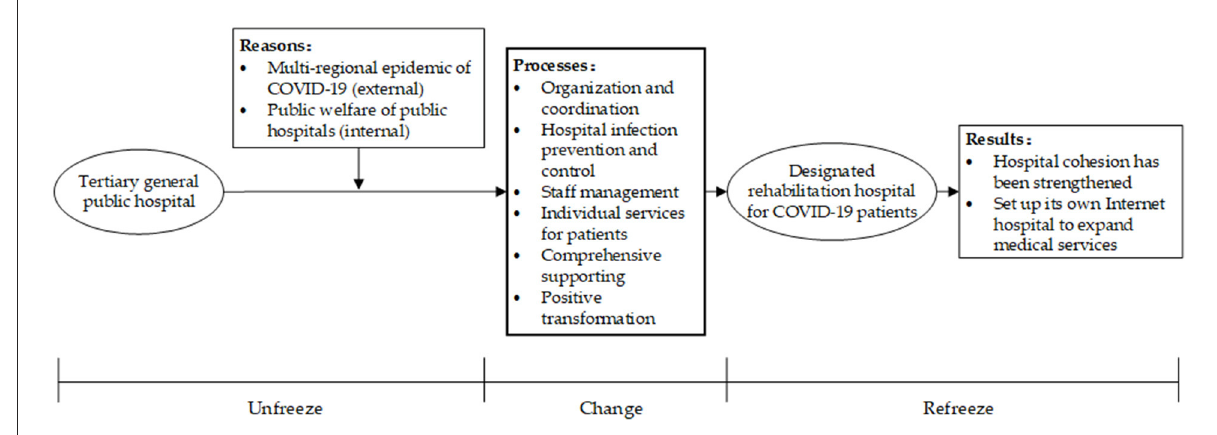
FIGURE3 The theoretical framework of the organizational self-transformation